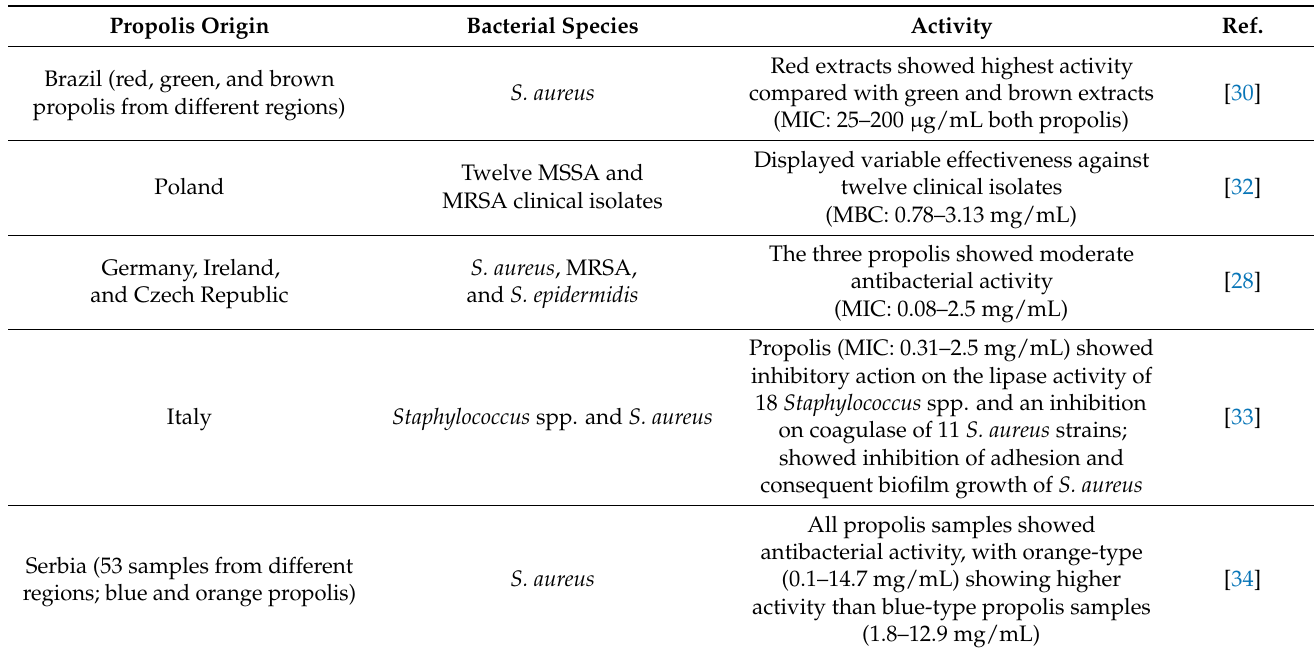
Table 1. Effect of propolis from several parts of the world on various Staphylococcus species. Propolis